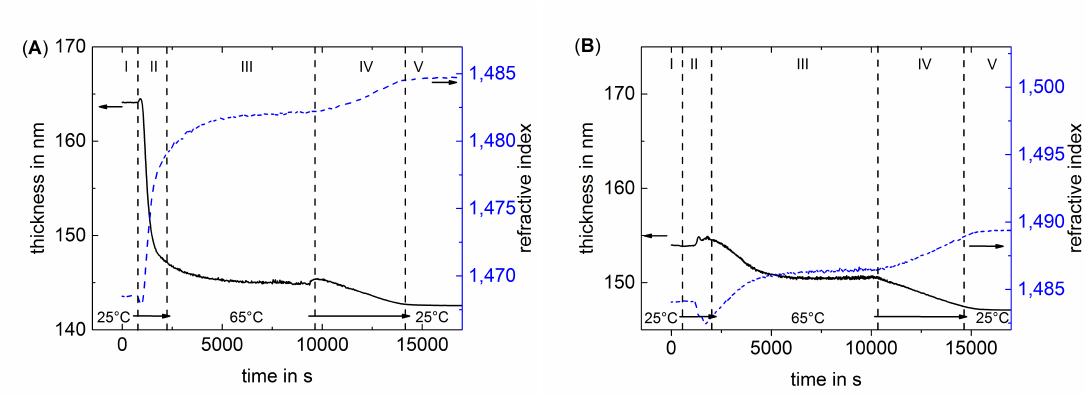
Figure 1. Change of thickness and refractive index over time during the temperature treatment measured in water by ellipsometry of samples with 36 layers ( A ) and 37 layers ( B ). The measurement begins at 25 ◦ C, then the temperature is increased to 65 ◦ C where it is maintained for 2 h. Then, the temperature was decreased back to 25 ◦